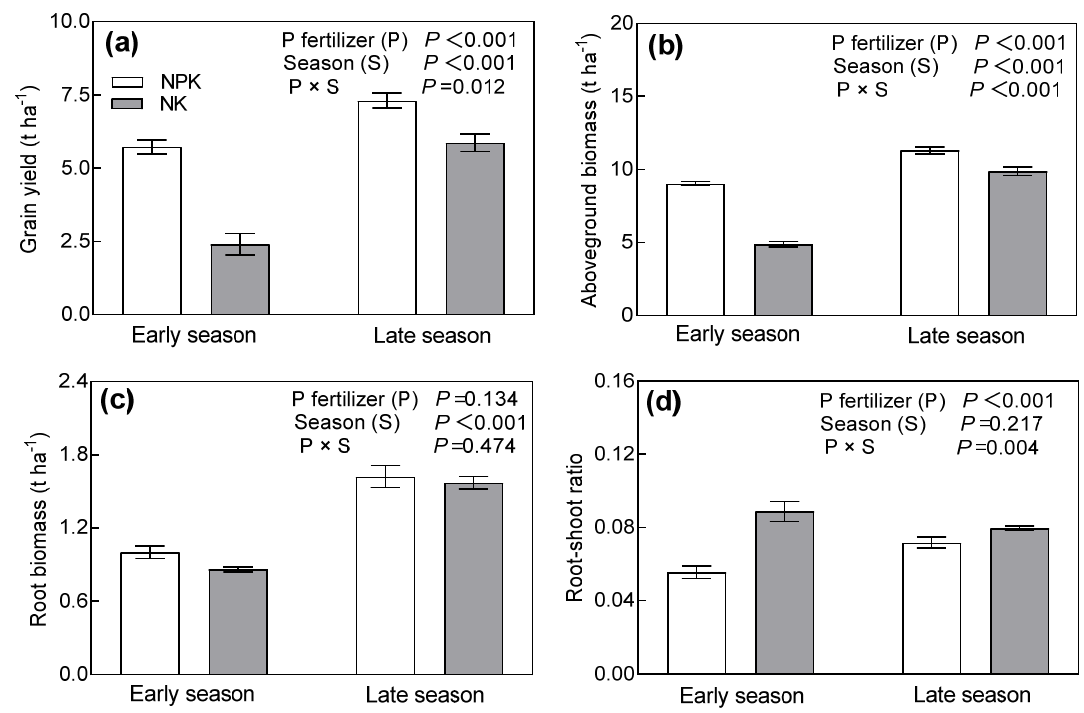
Figure 6. Grain yield ( a ), aboveground biomass ( b ), root biomass ( c ) and root–shoot ratio ( d ) under different long-term P addition treatments during early and late rice seasons. NPK: long-term N, P, and K fertilizers application; NK: long-term N and K fertilizers application. Error bars represent S.E. ( n = 3).